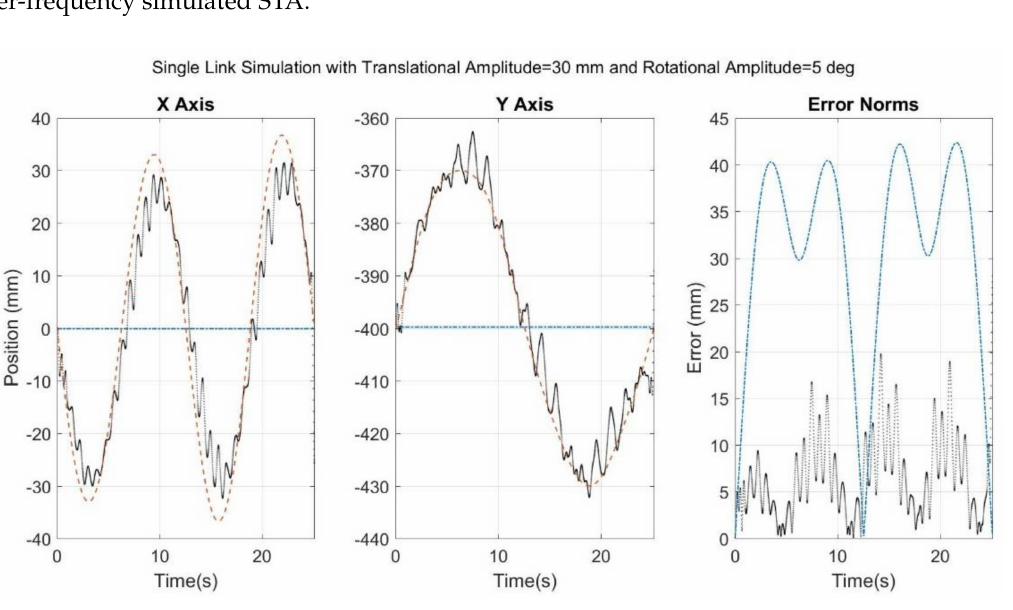
Figure 9. Results for simulation run with noise added to a rigid-link, spring-induced relative translational motion, and an induced relative rotational motion. Black dots refer to SFO, blue dash-dots to SOM, and red dashes to the theory.